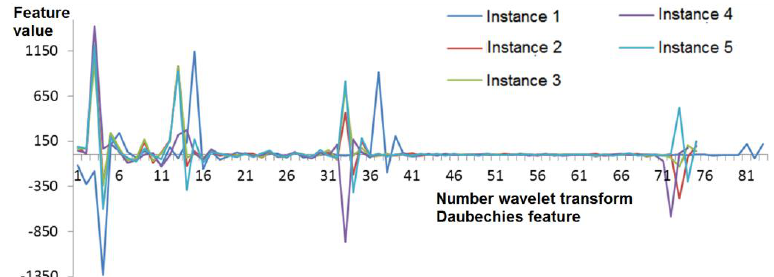
Figure 1. Wavelet transform coefficients before scaled by the pen pressure function (onto a tablet) to the mean length of a signature instance for a signer.